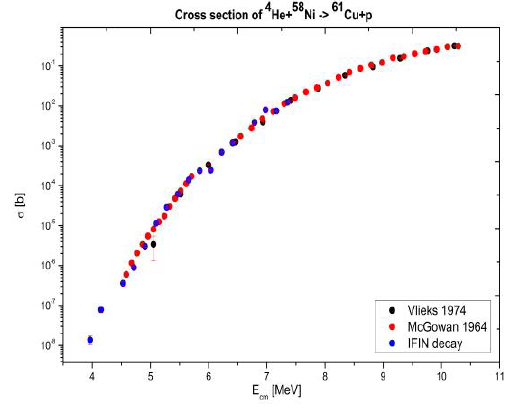
Figure 1. Comparison between the results obtained in IFIN and in the other